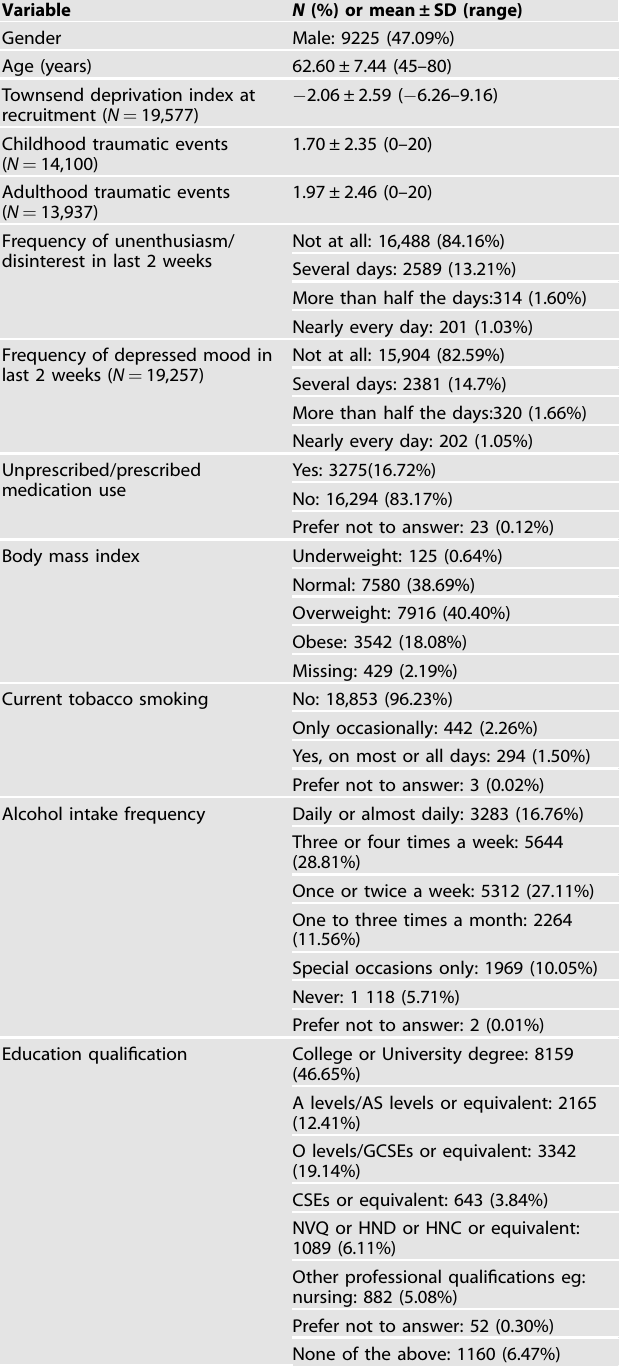
Table 1. Descriptive statistics for demographic variables ( N =